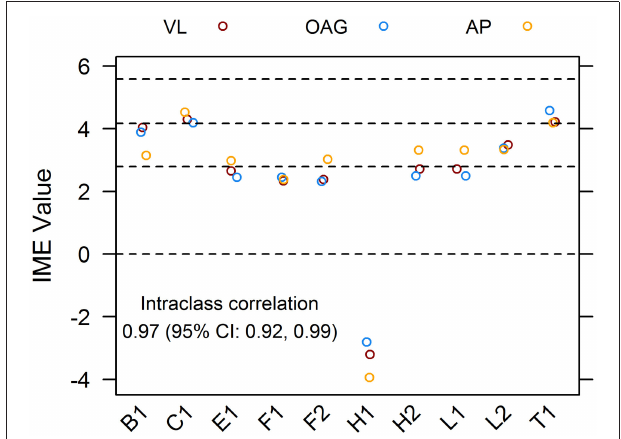
FIGURE 3 | Agreement of integrated metric of evidence (IME) values for ten randomized publications. Ten research papers from the pool of included records were randomly chosen and individually assessed by three reviewers, blind to each other’s scores. The interclass correlation between IME values was 0.97, demonstrating excellent reliability of the scoring system. Horizontal dotted lines indicate the threshold IME values between negligible and low (2.79), low and intermediate (4.14), and intermediate and high (5.58) levels of evidence.